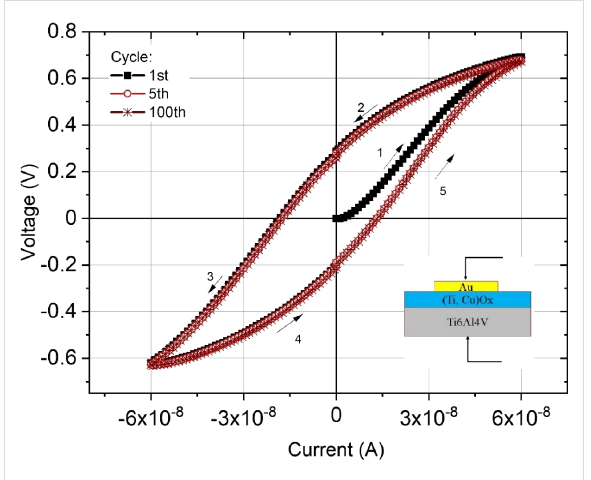
Figure 2: Direct current-to-voltage characteristics of the Au/(Ti–Cu)Ox/ TiAlV thin film structure. Arrows indicate the sequence of changes in current forcing during